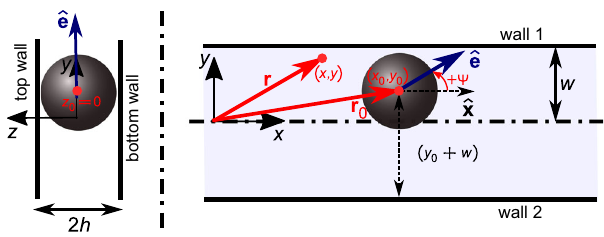
Fig. 7 Parameters and variables. Schematic of the active droplet in the microchannel with